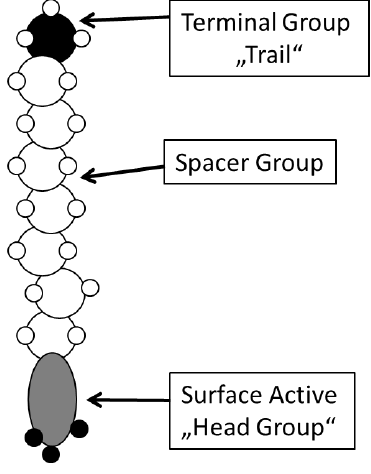
Figure 6. Molecules for self